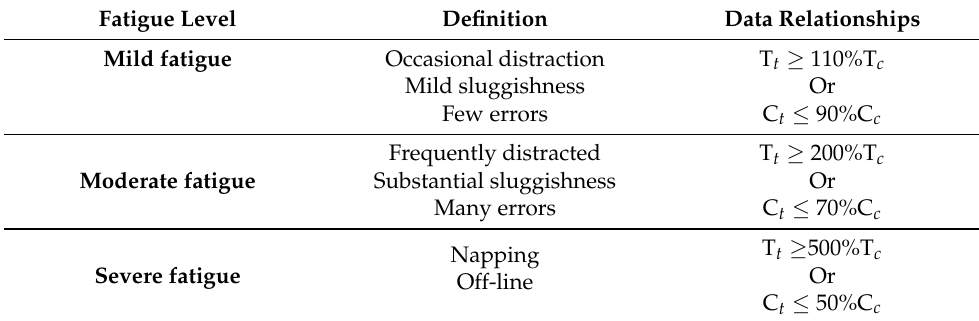
Table 2. Definition of fatigue